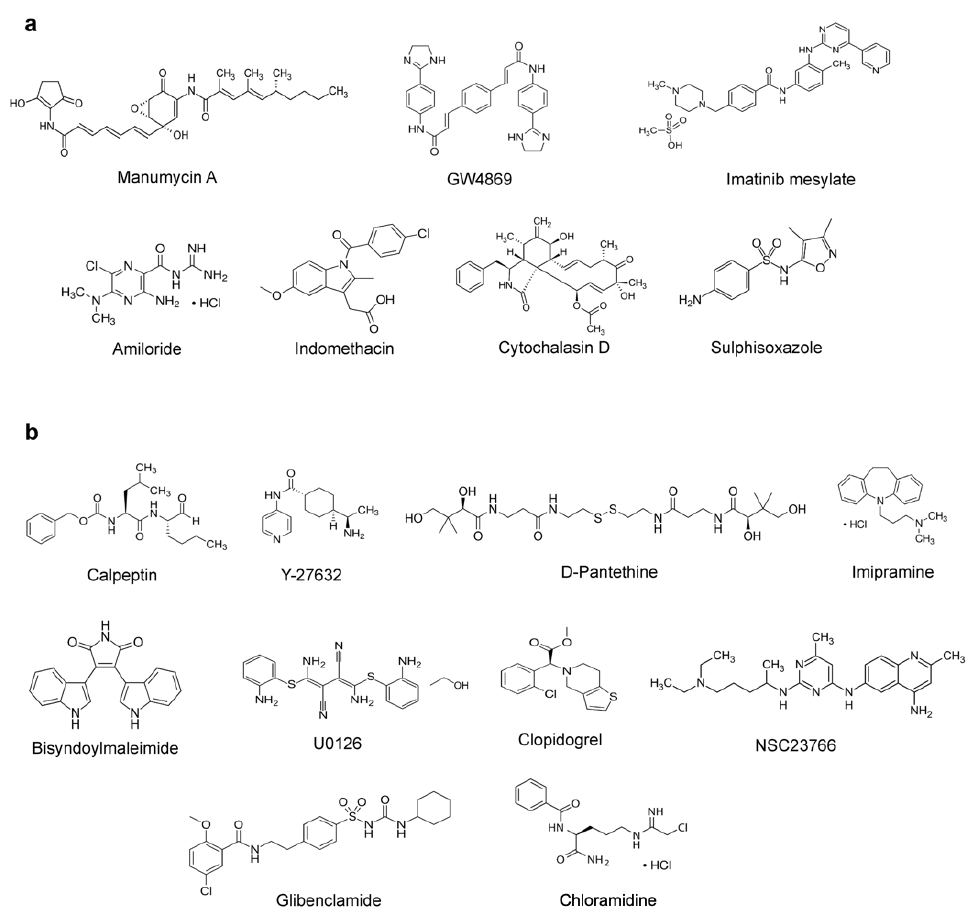
Figure 1. EV inhibitors for screening as anti-SARS-CoV-2 agents in this study. ( a ) Exosome production and release inhibitors. ( b ) Microvesicle generation inhibitors. Targets and mechanism of action (MOA) of these compounds are provided in Supplementary Materials Table S1.